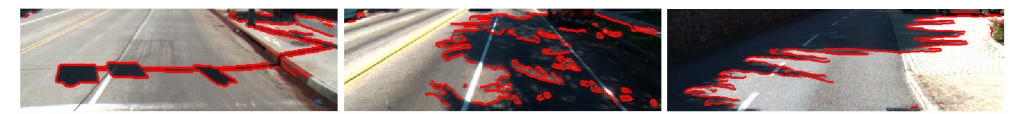
Figure 11. Examples of the results of the shadow edge detection method (images obtained from [19]).